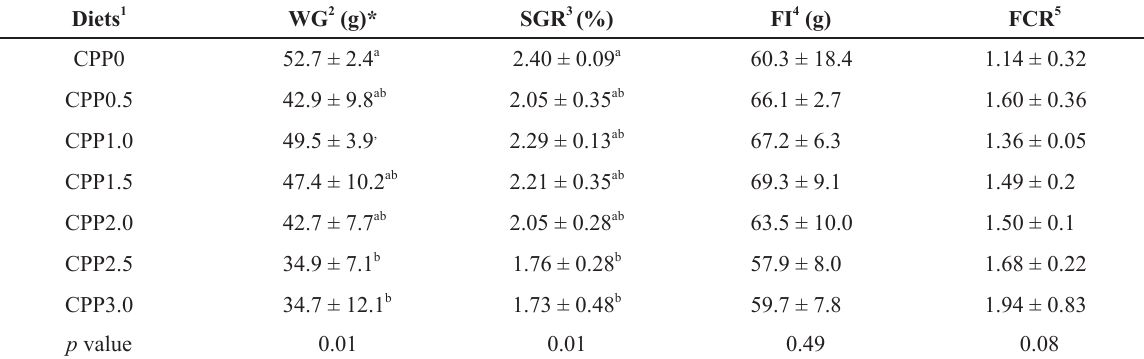
Growth performance of Nile tilapia fed graded levels of dietary crude propolis